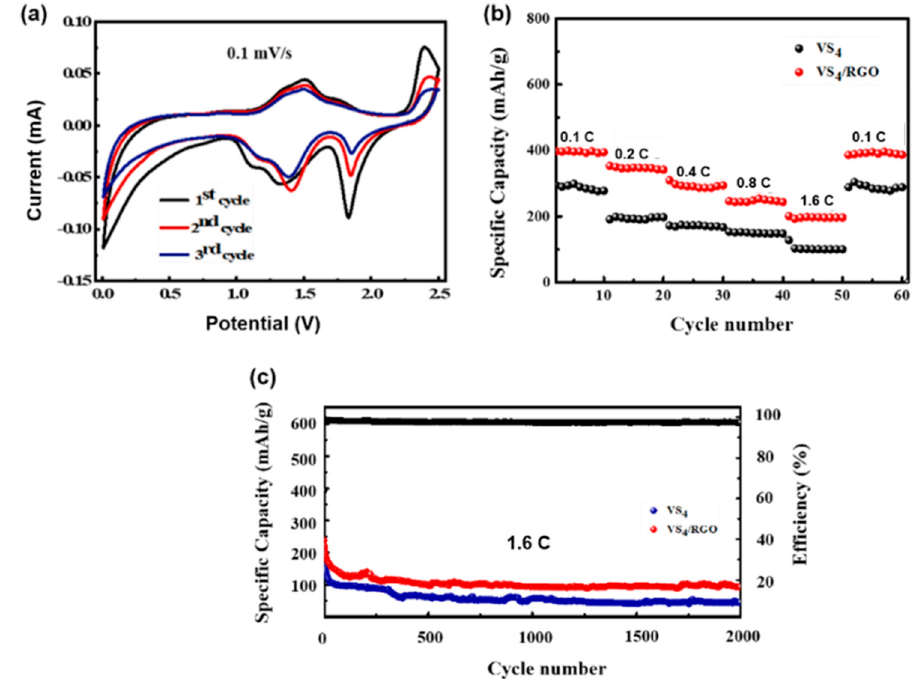
Figure 5. Electrochemical measurements of VS 4 /RGO nanocomposites in comparison with nanorods and RGO: ( a ) CV curves for the initial cycles at the scanning rate of 0.1 mV/s of VS 4 /RGO nanocom- posites; ( b ) rate performance at the different densities; ( c ) long-term stability performance at the current density of 1.6 C.